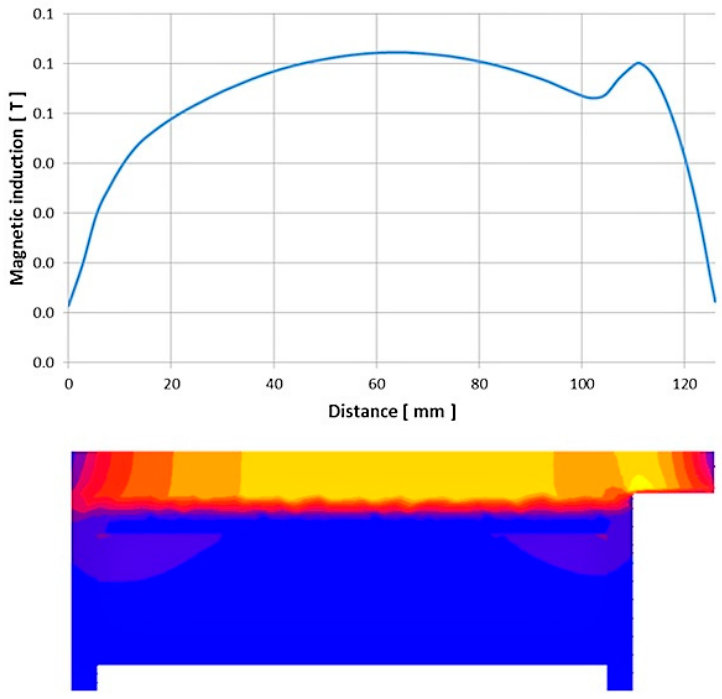
Figure 9. Magnetic induction in the middle of the coil of the MRE sample from the coil position towards the sample.